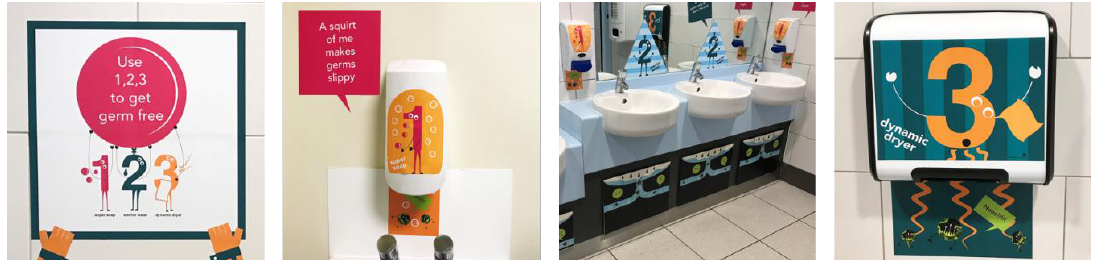
Figure 1. Example “123” persuasive space graphics (PSG).